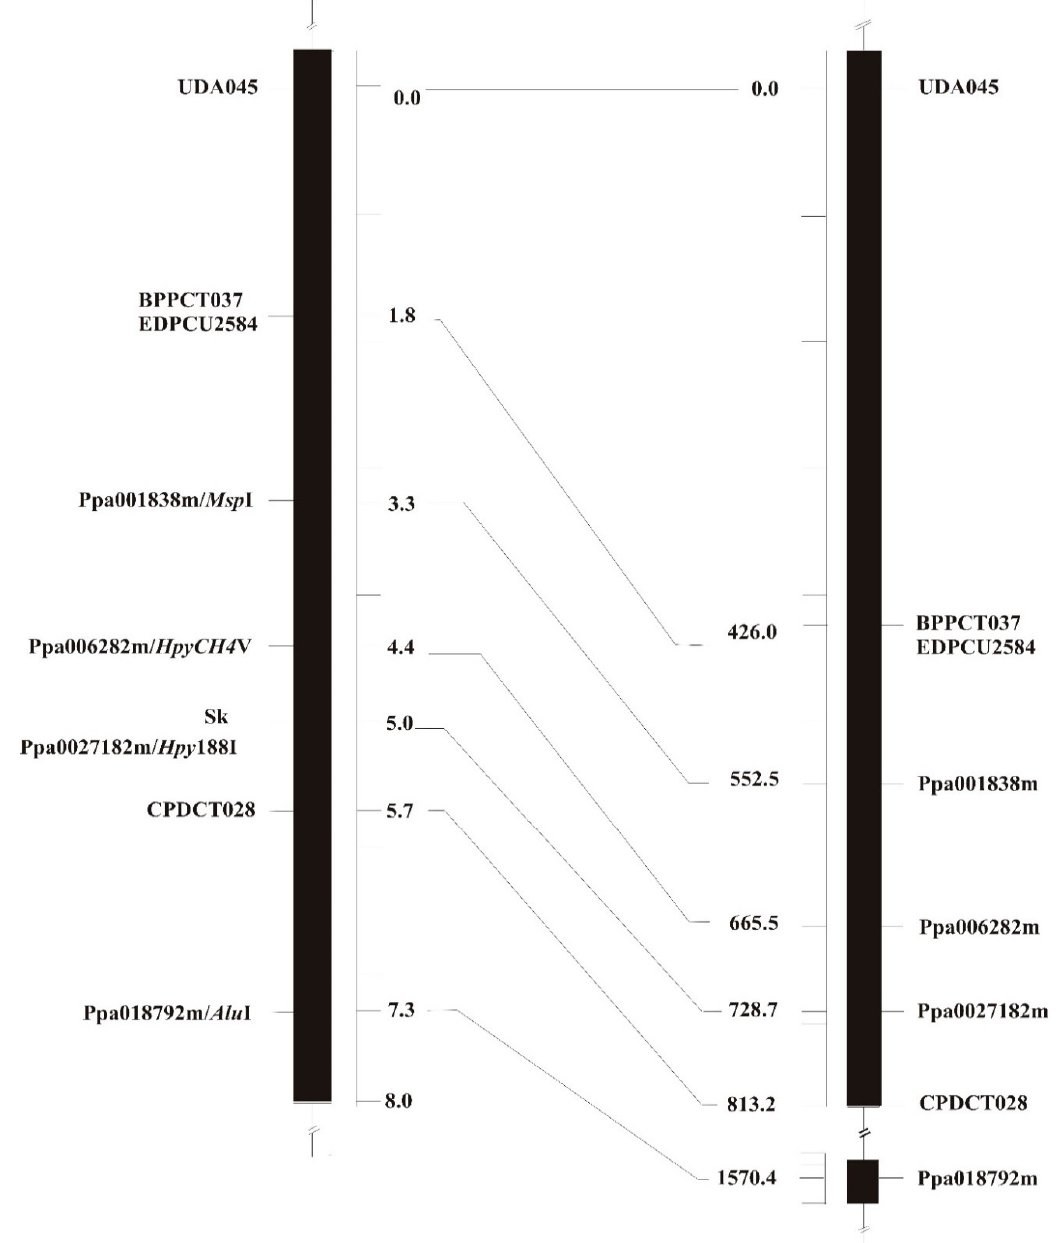
Figure 2. Syntenic relationship between the almond Sk linkage map ( left ) and the peach physical map ( right ) in the Sk genomic region. Table 3. Features of peach genes included in the physical interval delimited by ppa006282m and CPDCT028.